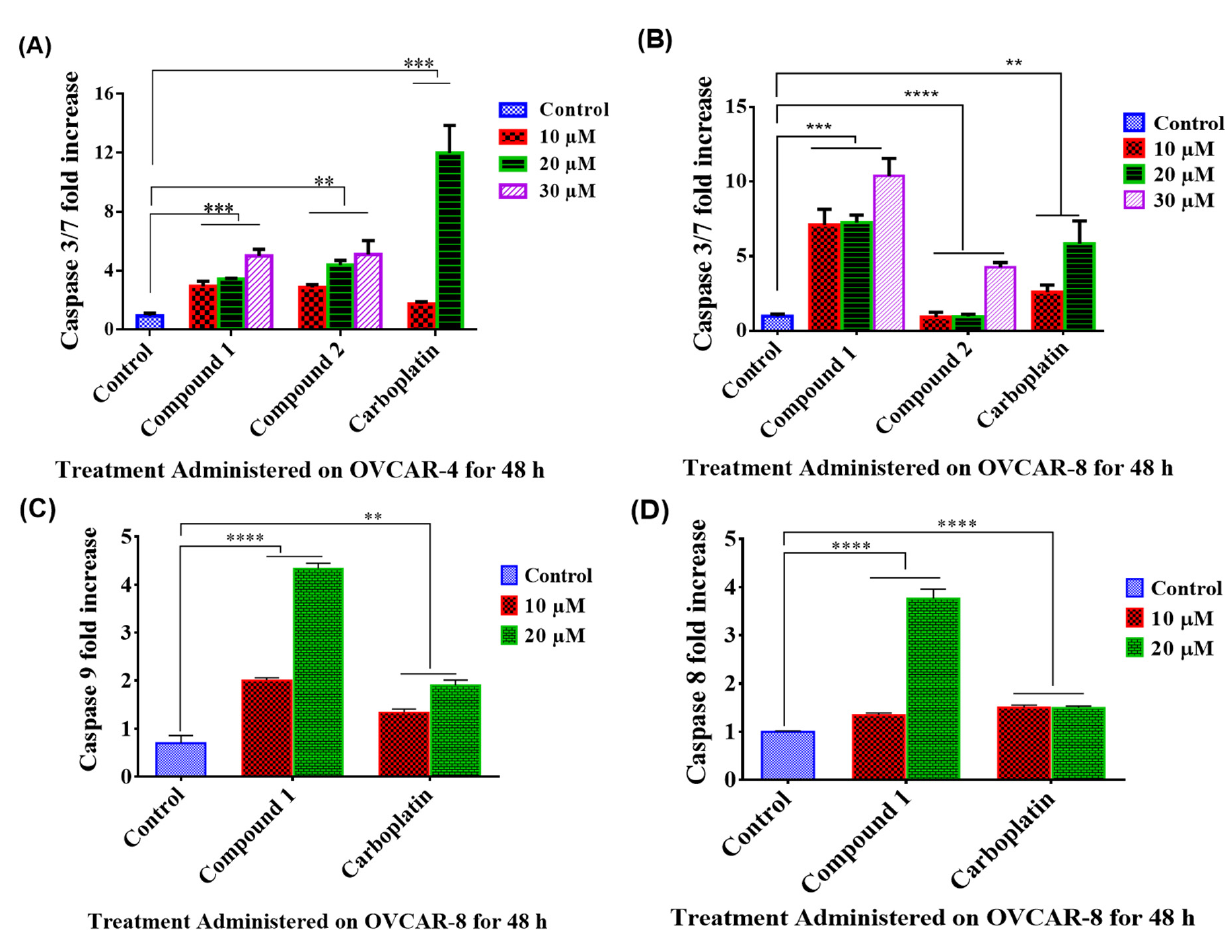
Figure 3. Caspase activities of compound 1 and 2 in ovarian cancer cells. Caspase 3/7 activities of isolated compound 1 and 2 in OVCAR-4 ( A ) and OVCAR-8 ( B ) cells; and caspase 8 activity ( C ) and caspase 9 activity ( D ) of compound 1 in OVCAR-8 cells. Carboplatin was used as positive control. The fold increase in caspase activities induced by compound 1 and positive control were compared with the negative control using one-way ANOVA with Dunnett’s multiple comparison test. Significant difference between treatment and control is denoted with asterisk (*) and student t test was used to test for concentration dependent activity.